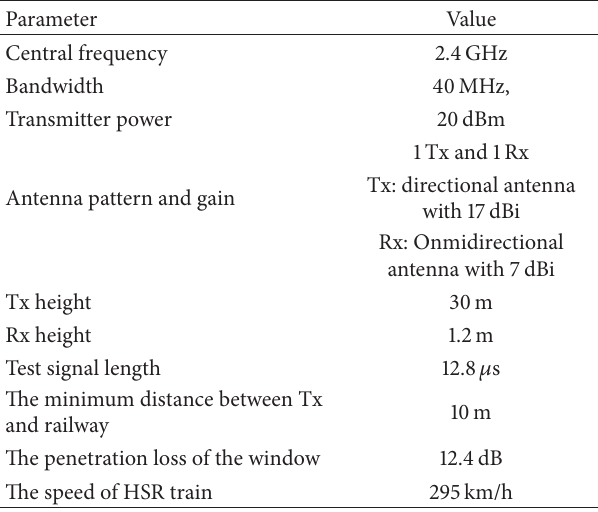
Figure 2: (a), (b) are photos of the propagation environments at the transmit side and receive side, respectively. Table 1: Parameters of the measurement